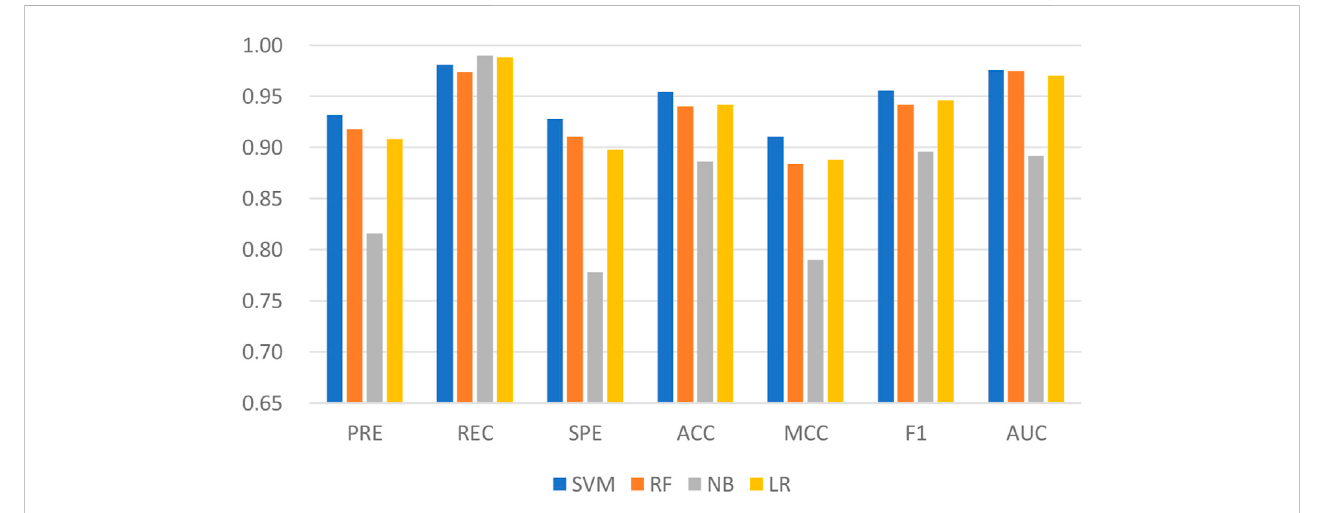
FIGURE 4 Comparison of the performance of LPIH2V and other classi fi ers.